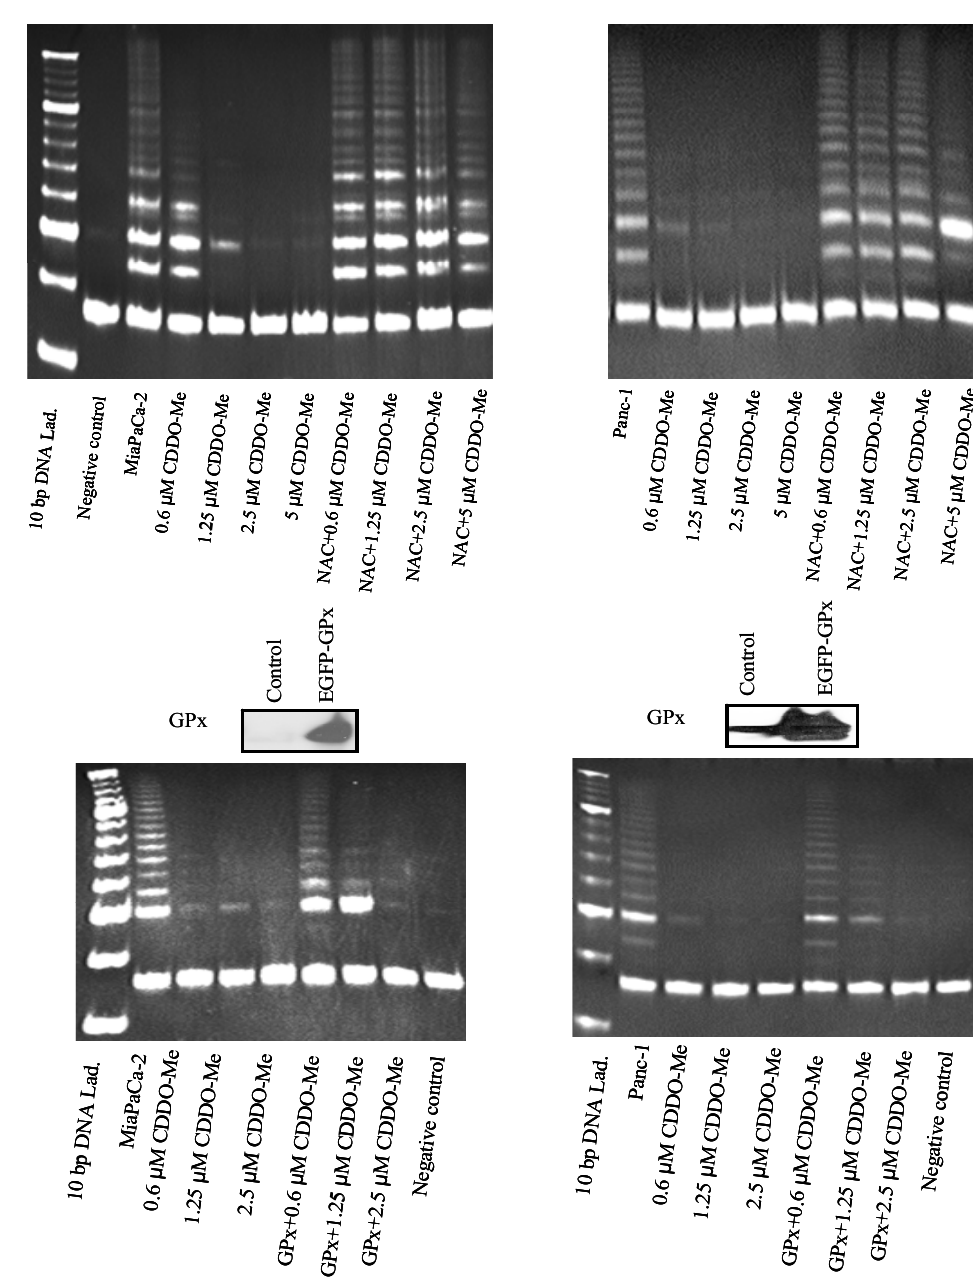
Figure 3. CDDO-Me inhibits telomerase activity and antioxidants block it. ( A ) Effect of NAC. MiaPaCa-2 and Panc-1 cells pretreated or not with NAC (3 mM) for 2 h were treated with CDDO-Me (0–10 μ M) for 48 h and telomerase activity of cell extracts was measured by TRAP assay as described in Materials and Methods. DNA laddering patterns under different treatment conditions are shown. Experiments were repeated two times. NC, negative control (no cell extract); ( B , C ) Effect of overexpression of antioxidant enzymes GPx and SOD-1. MiaPaCa-2 and Panc-1 cells were transfected with GPx or SOD-1 expression plasmids using LipofectAMINE Plus reagent for 48 h. Overexpression of enzymes was confirmed by immunoblotting and cells were then treated with CDDO-Me at 0.625–5 µM for 48 h and telomerase activity was measured by TRAP